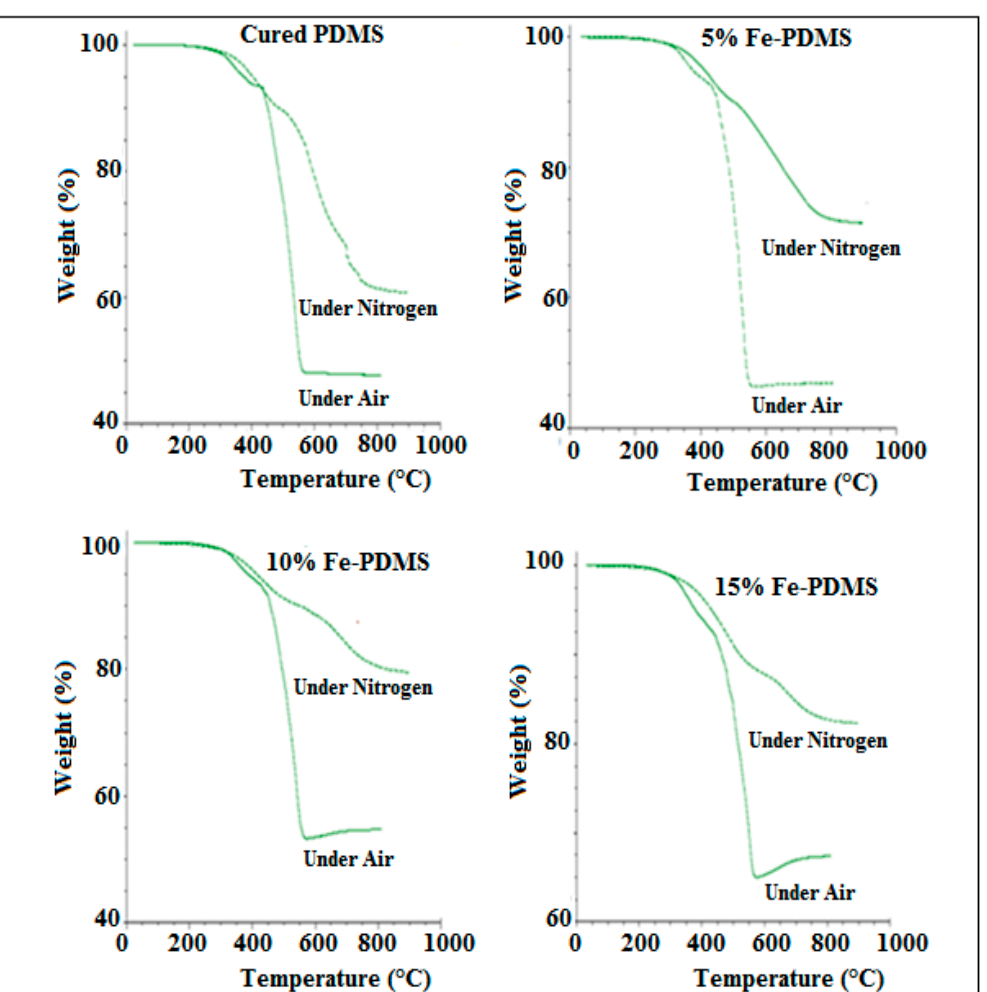
Figure 7. TGA of cured PDMS and PDMS composites as a function of gas atmosphere.